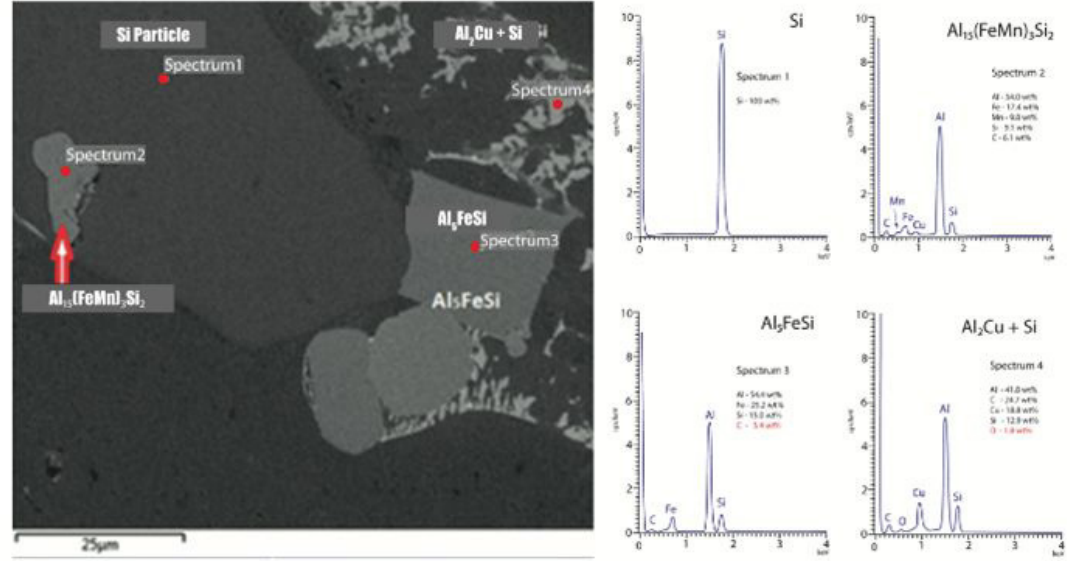
Figure 7. SEM images of the sample submitted to solution treatment at 540ºC and ageing 190ºC/4h. EDS spectra of each microconstituent is shown on the right.